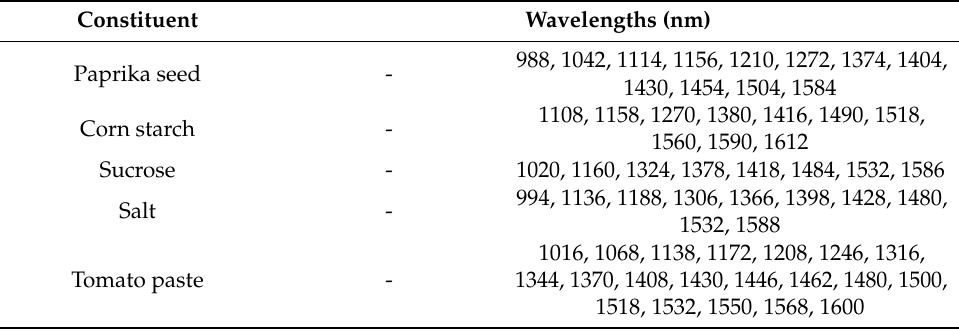
Table 8. Relevant wavelengths in the adulterant concentration predictions with PLSR and “LOSOCV” validation on pre-treated NIRS spectra of authentic and adulterated tomato